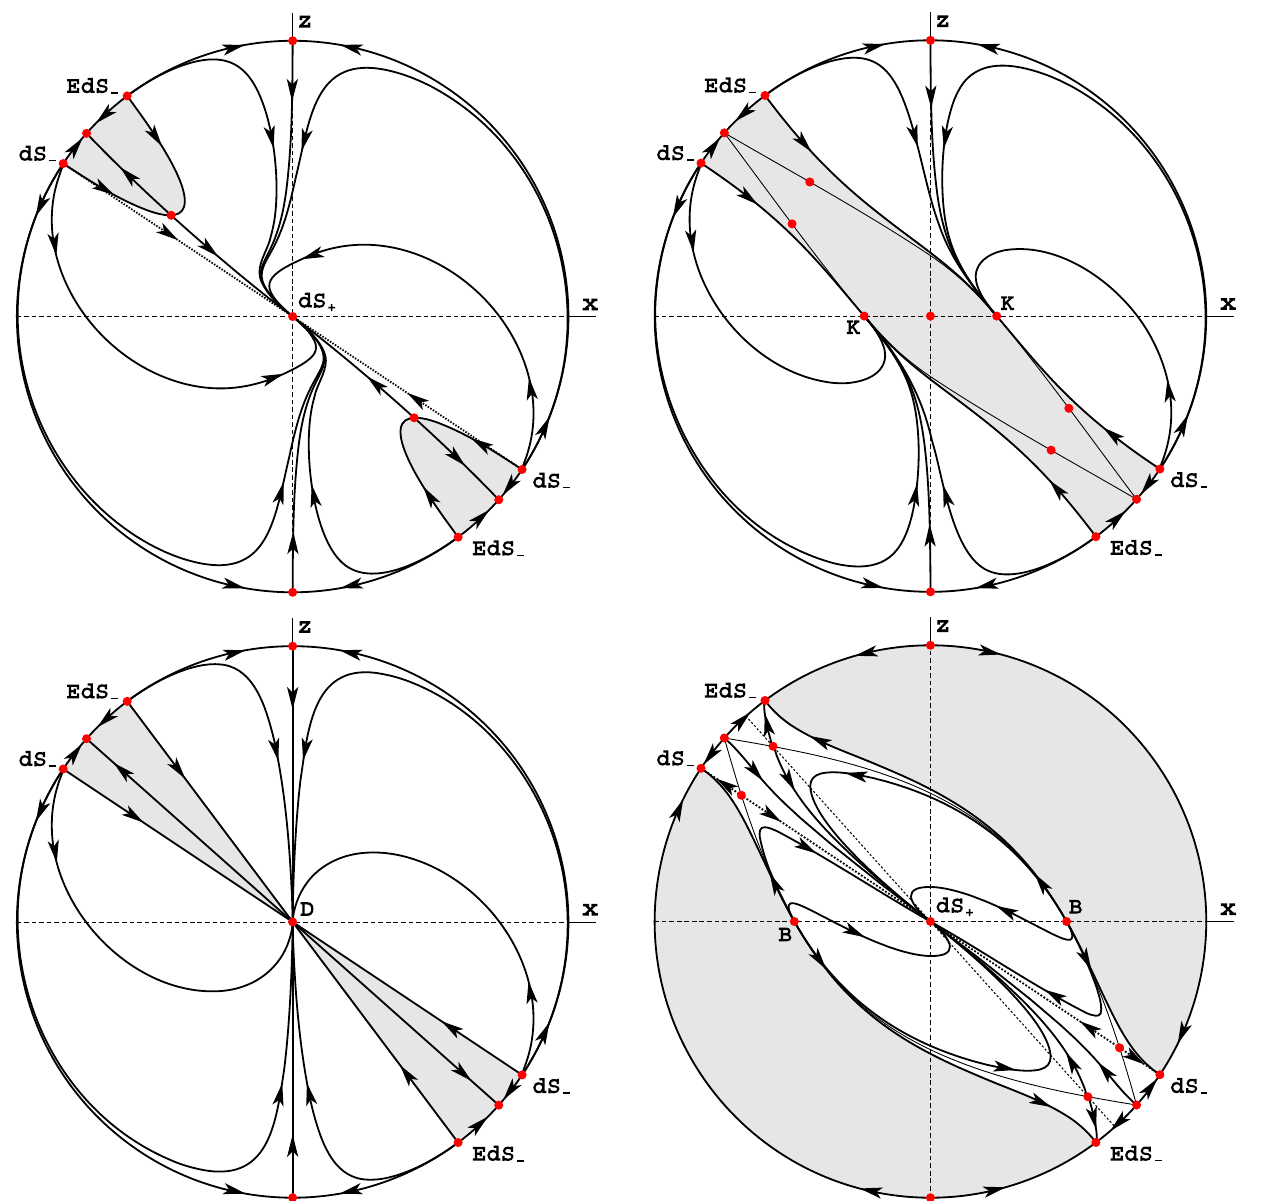
Fig. 5 The phase space diagrams representing evolutional paths in the Fig. 6 The phase space diagrams representing evolutional paths in the phase space compactified with the circle at infinity for models with a phase space compactified with the circle at infinity for models with , Ω (cid:16), 0 > 0 (top); and with , Ω (cid:16), 0 < 0 (top); and canonical scalar field ε = + 1 and ξ = 3 the canonical scalar field ε = + 1 and ξ = 3 16 16 Ω (cid:16), = 0 (bottom). The shaded regions where the energy conservation , Ω (cid:16), 0 > 0 (bottom). The the phantom scalar field ε = − 1 and ξ = 3 0 16 condition (36) is negative are nonphysical. The direction of arrows in shadedregionswheretheenergyconservationcondition (36)isnegative the physical regions of the phase space corresponds to expansion of are nonphysical. Note a complementarity between evolutional paths in universe. The dotted trajectory on the first diagram corresponds to the a physical regions of the phase pure de Sitter type of evolution. On the bottom diagram at the centre we can observe that the critical points from the previous diagram merge giving rise to a degenerated critical points with an asymptotically stable regions in the physical parts of the phase space. The vanishing cosmo- logical constant Ω (cid:16), 0 = 0 is the bifurcation value for dynamics of the model